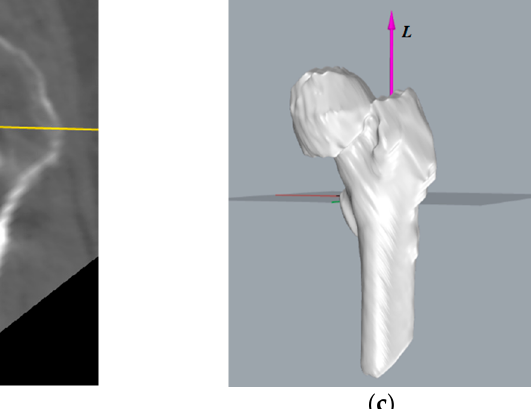
Figure 9. According to the projection of the medullary cavity centerline in plane 1 (red line) and plane 2 (blue line), we located the position of: ( a ) plane 1, ( b ) plane 2, and ( c ) the centerline in the 3D model.